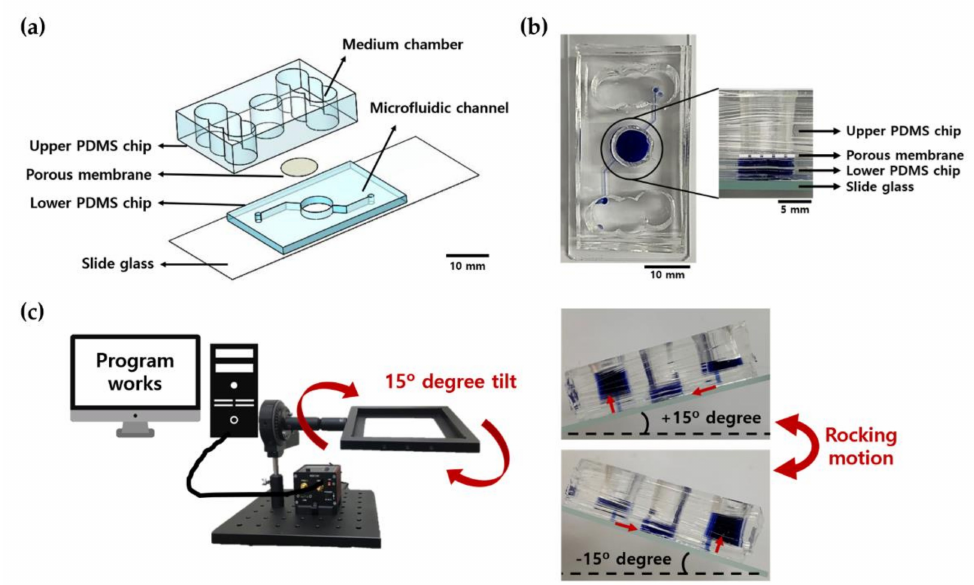
Figure 9. Schematic diagram of the pumpless skin-on-a-chip (SOC) and gravity flow system in action. ( a ) Configuration diagram of pumpless microfluidic skin-on-a-chip. ( b ) Actual appearance of pumpless SOC. The microfluidic channel of the lower chip is filled with blue dye and an enlarged side view of the culture chamber. ( c ) Schematic diagram of the operation of the gravity flow system. It works by shaking both sides at 15 ◦ . The 15 ◦ slope allows the medium to circulate through the microfluidic